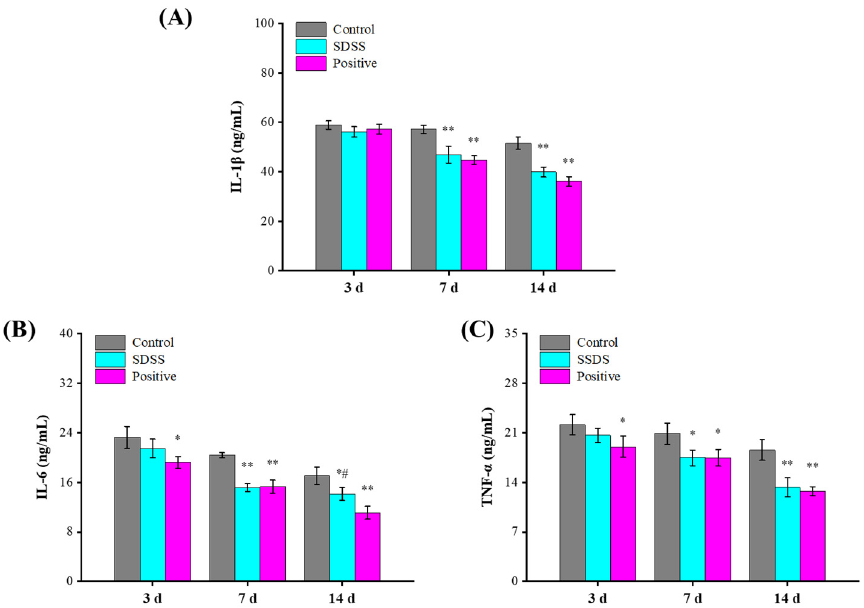
Figure 4. Effect of SDSS on serum levels of inflammatory factors ( n = 5). ( A ) IL-1 β level; ( B ) IL-6 level; ( C ) TNF- α level. * p < 0.05, ** p < 0.01 when compared to the control group. # p < 0.05 when compared to the positive group.